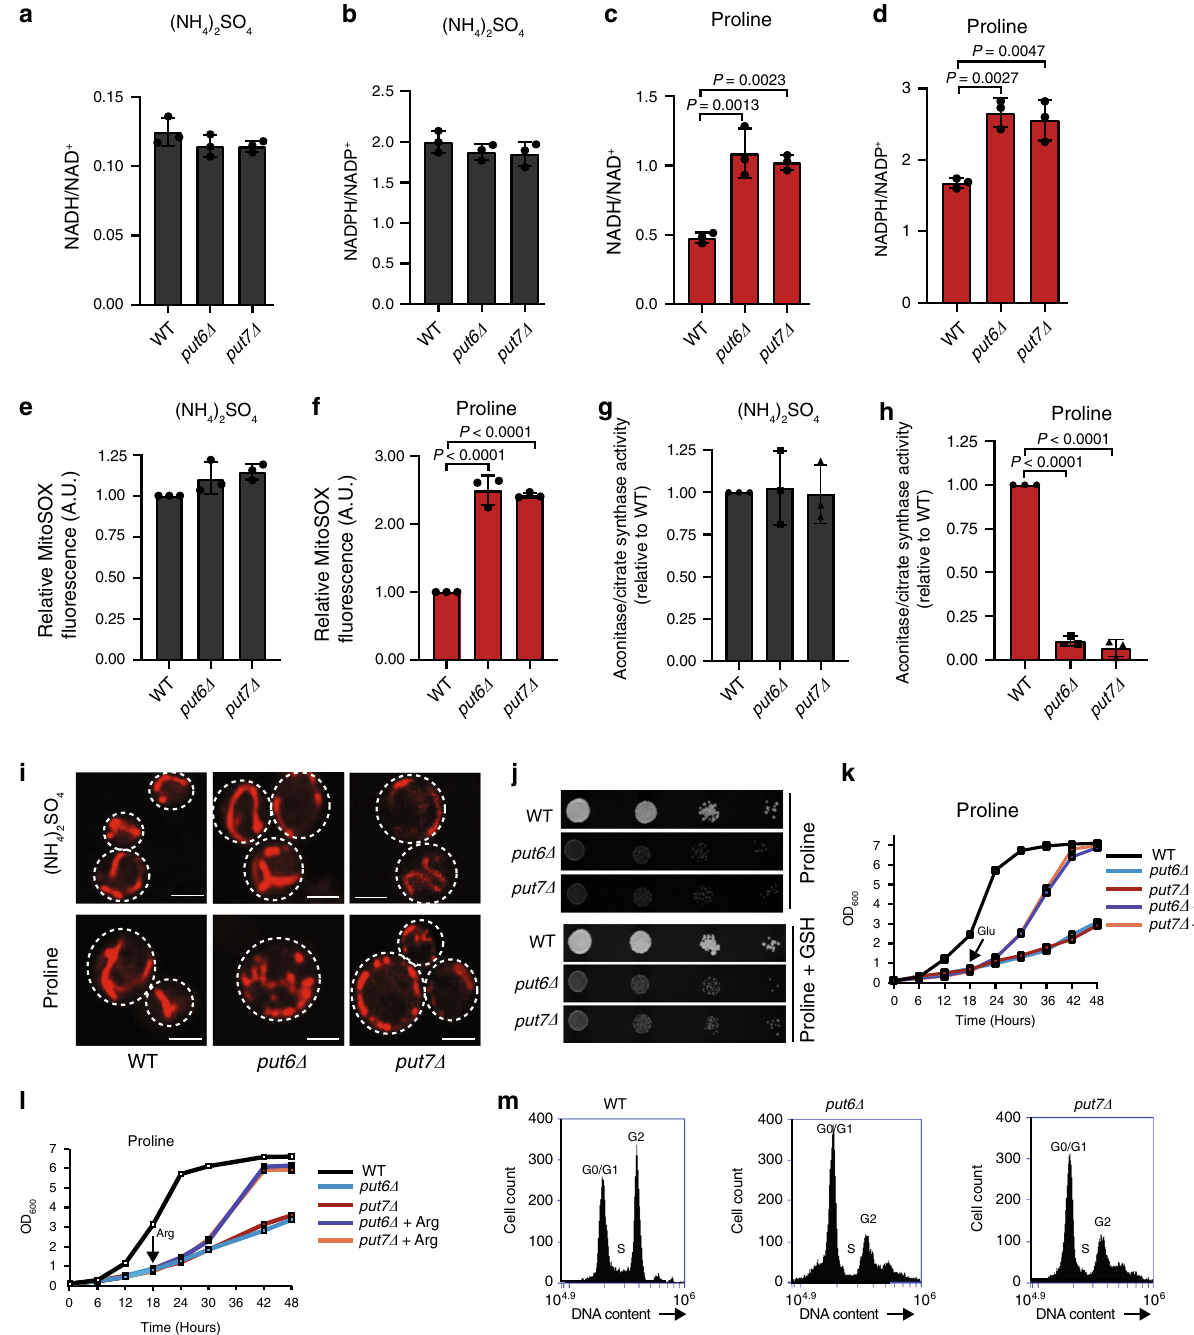
Fig. 6 Loss of Put6 and Put7 perturbs cellular redox homeostasis. a – d NADH/NAD + and NADPH/NADP + in WT, put6 Δ , and put7 Δ yeast cells when grown on synthetic galactose media with ammonium sulfate ( a and b ) or proline ( c and d ) as the sole nitrogen source. Data are expressed as mean ± SD ( n = 3 biologically independent experiments). e , f Mitochondrial ROS measured using MitoSOX fl uorescence. Data are expressed as mean ± SD ( n = 3 biologically independent experiments). g , h Aconitase activity in isolated mitochondria from WT, put6 Δ , and put7 Δ yeast cells. Aconitase activity was normalized to citrate synthase activity and is expressed as mean ± SD relative to WT ( n = 3 biologically independent experiments). i Indicated yeast cells were stained with the Mitotracker Red CMXRos and visualized using confocal microscopy (scale bar 2.44 µ m). j Ten-fold serially diluted yeast cells were seeded on synthetic media plates containing proline as the sole nitrogen source ± 0.5 mM reduced glutathione (GSH). Pictures were taken after 3 days of seeding. The data are representative of three independent experiments. k , l Growth measurement of WT, put6 Δ , and put7 Δ yeast cells in proline-containing media followed by 4 mM glutamate ( k ) or 4 mM arginine ( l ) addition after 18 h of growth (indicated by an arrow). Data are representative of three independent experiments. m Cell-cycle analysis of proline grown WT, put6 Δ , and put7 Δ cells by fl ow cytometry. Statistical signi fi cance was assessed by one-way analysis of variance (ANOVA) with Tukey ’ s multiple comparison test. WT and mutants used in this panel are from prototrophic ACY genetic background (see Supplementary Table 1). Source data are provided as a Source data fi